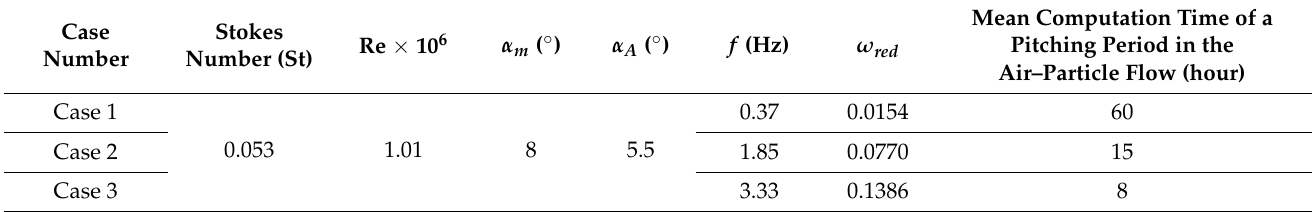
Table 2. The parameters of three pitching cases and their mean computational